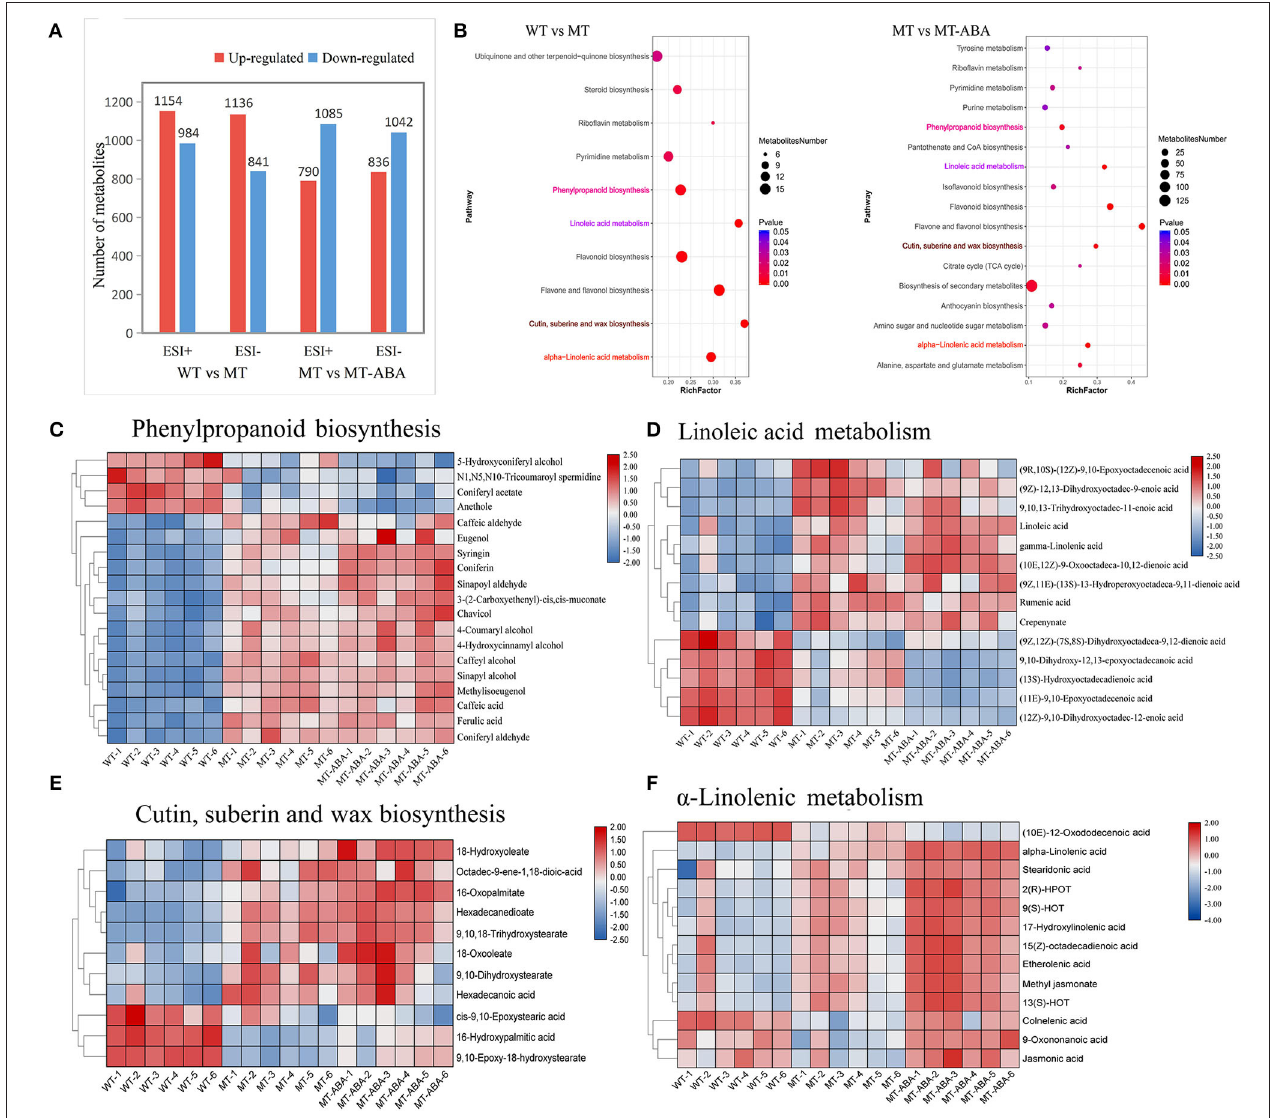
FIGURE 3 | Differential metabolite analysis of pear exocarp. (A) Quantity statistics of DMs. (B) KEGG enrichment analysis of significant DMs. (C) Heatmap of DMs involved in phenylpropanoid biosynthesis. (D) Heatmap of DMs involved in linoleic acid metabolism. (E) Heatmap of DMs involved in cutin suberin and wax biosynthesis. (F) Heatmap of DMs involved in α -linolenic acid metabolism. WT, ‘Dangshansuli’. MT, ‘Dangshanjinsu’. MT-ABA, ‘Dangshanjinsu’ treated with exogenous